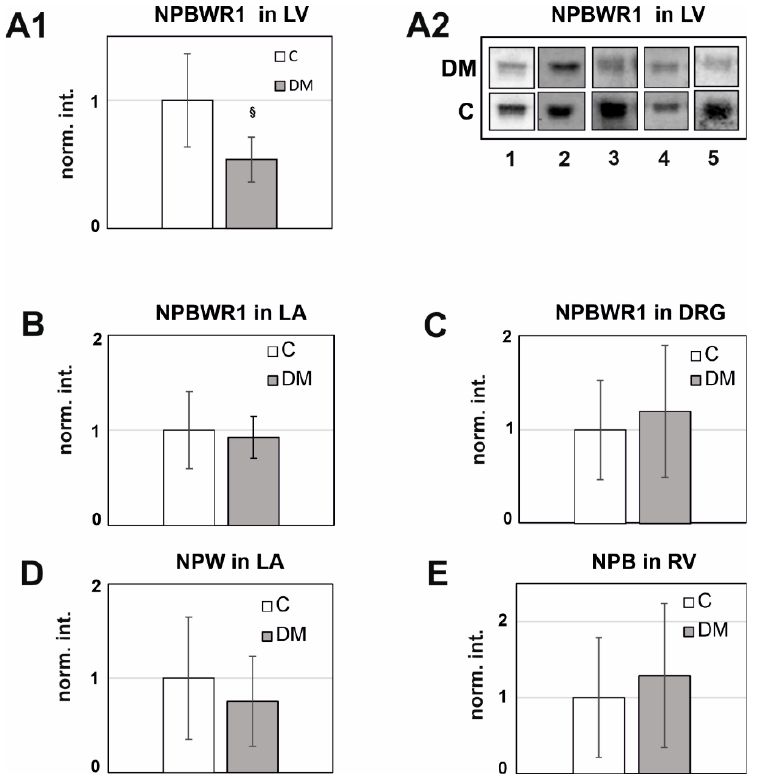
Figure 3. The quantitative WB analysis of rat heart tissues and DRG. Western blot (WB) analyses were performed using commercially available antibodies against NPB (1:200), NPW (1:1000), and NPBWR1 (1:2000) on selected tissues showing significant differences in qPCR analysis. Twenty-five µg of protein from the separated heart chamber was subjected to SDS-PAGE 12.5% and used for the WB analysis. ( A1 ): LV from the diabetic rat ( n = 5) versus the control rat ( n = 5) using anti-NPBWR1 (1:2000) was used in WB. The signal ratio DM/C was 0.53 ( p = 0.046). ( A2 ): Immunogenic bands of NPBWR1 from LV of the diabetic heart versus the control heart. ( B ): LA from the diabetic rat ( n = 6) versus the control rat ( n = 6) using anti-NPBWR1 (1:2000). The signal ratio DM/C was 0.93 ( p = 0.71). ( C ): DRG from the diabetic rat ( n = 7) versus the control rat ( n = 7) using anti-NPBWR1 (1:2000). The signal ratio DM/C was 1.21 ( p = 0.55). ( D ): LA from the diabetic rat ( n = 5) versus the control rat ( n = 5) using anti-NPW (1:1000). The signal ratio DM/C was 0.86 ( p = 0.74). ( E ): RV from the diabetic rat ( n = 7) versus the control rat ( n = 7) using anti-NPB (1:200). The signal ratio DM/C was 1.29 ( p = 0.55). The final expression ratio in the diabetic animals was calculated by a t -test, where the average diabetic rat tissue signal was divided by the average control rat tissue signal in each group. All the data are expressed as the mean ± standard deviation. The values of p < 0.05 were considered statistically significant. § p < 0.005 (Mann–Whitney test)